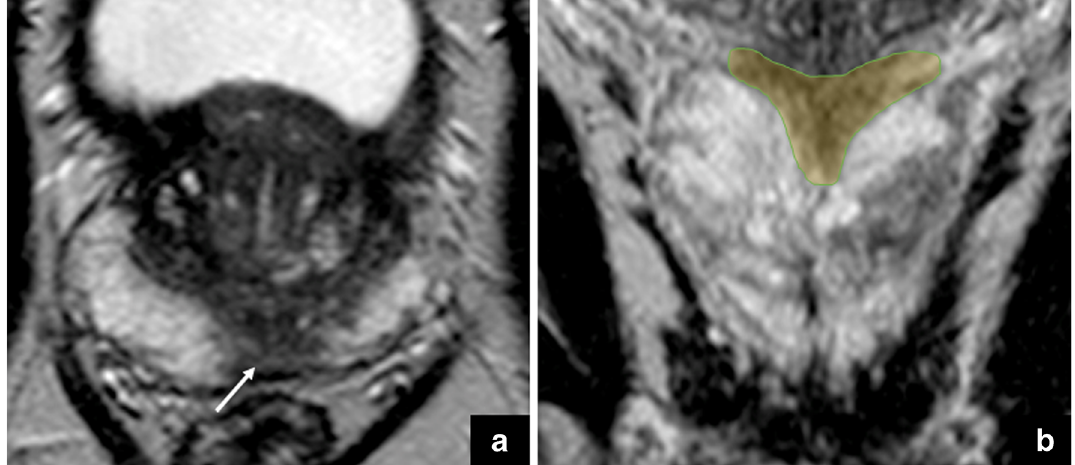
Fig. 7 Axial T2-weighted image ( a ) that shows a hypointense area at the prostate base, in the peripheral zone. This aspect is a variant/extension of the moustache sign , in which the central zone is compressed between the